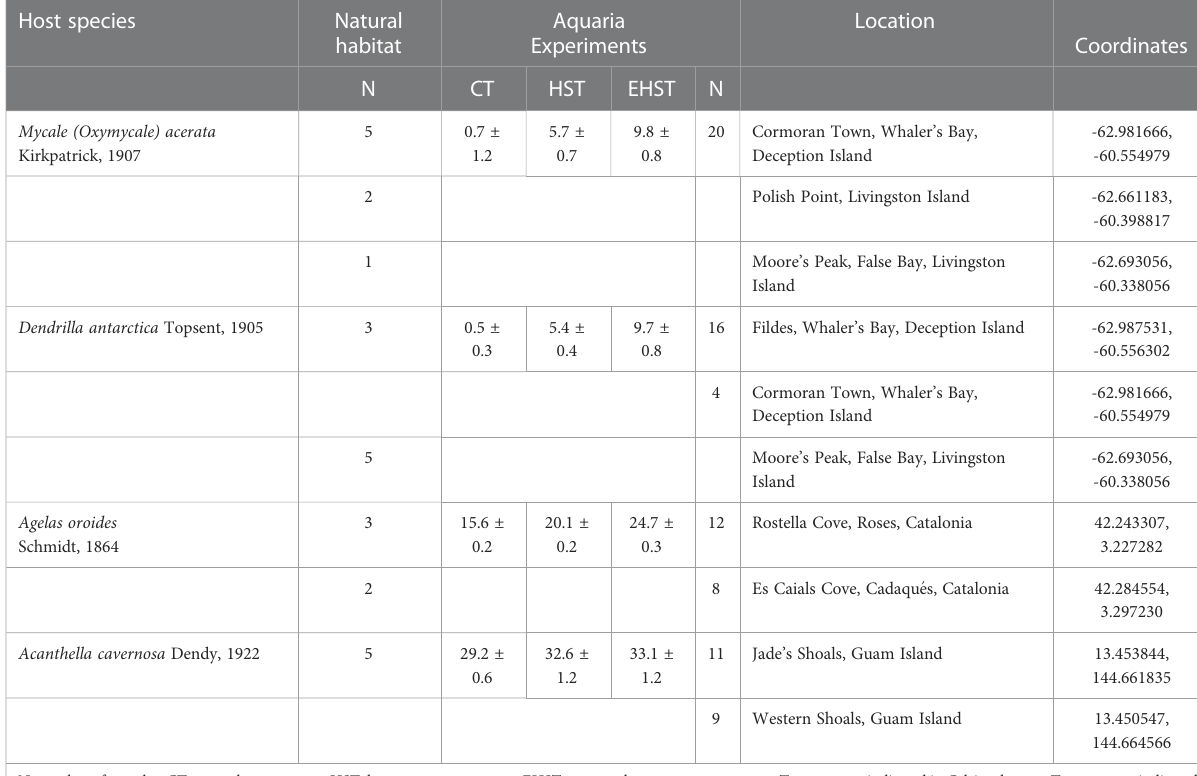
TABLE 1 Samples, number of sponge specimens, experimental conditions and sampling sites coordinates of the different specimens. Host